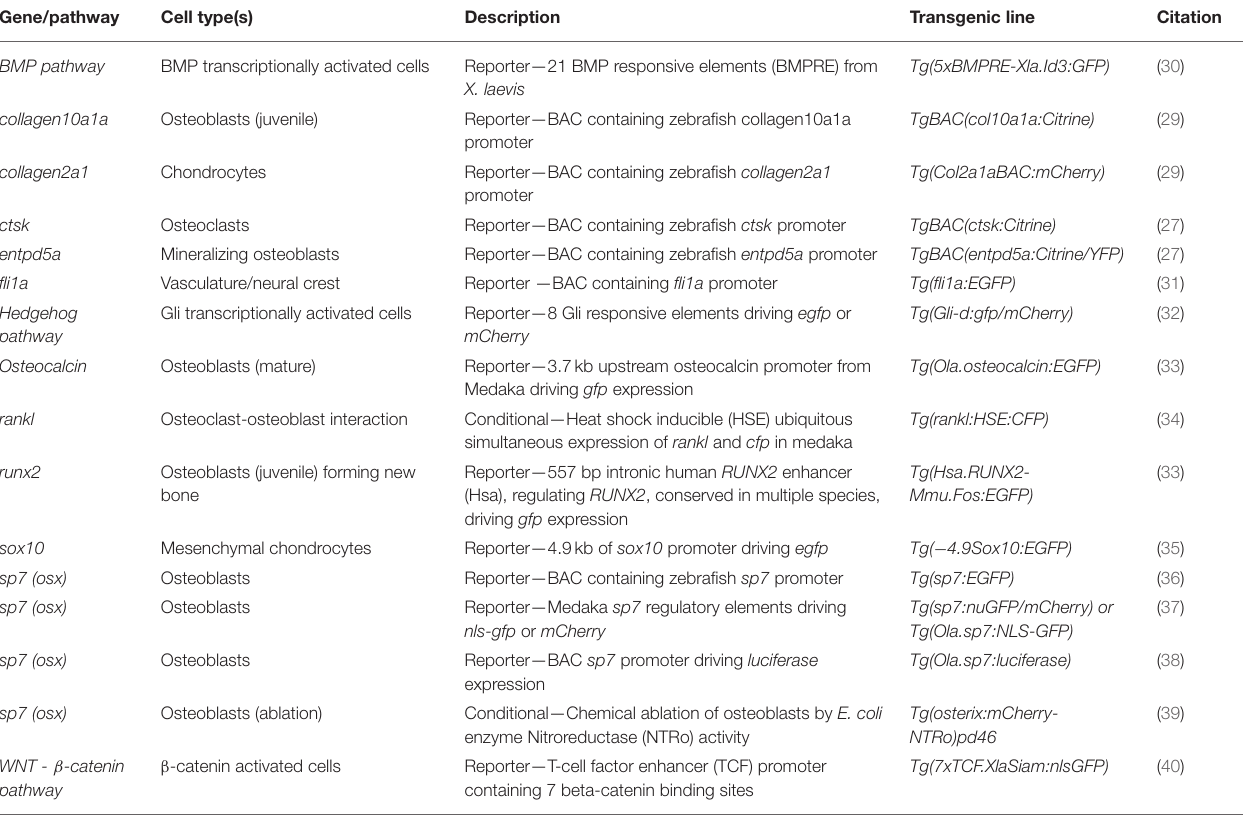
TABLE 1 | Common transgenic lines to study musculoskeletal system in small teleostei.